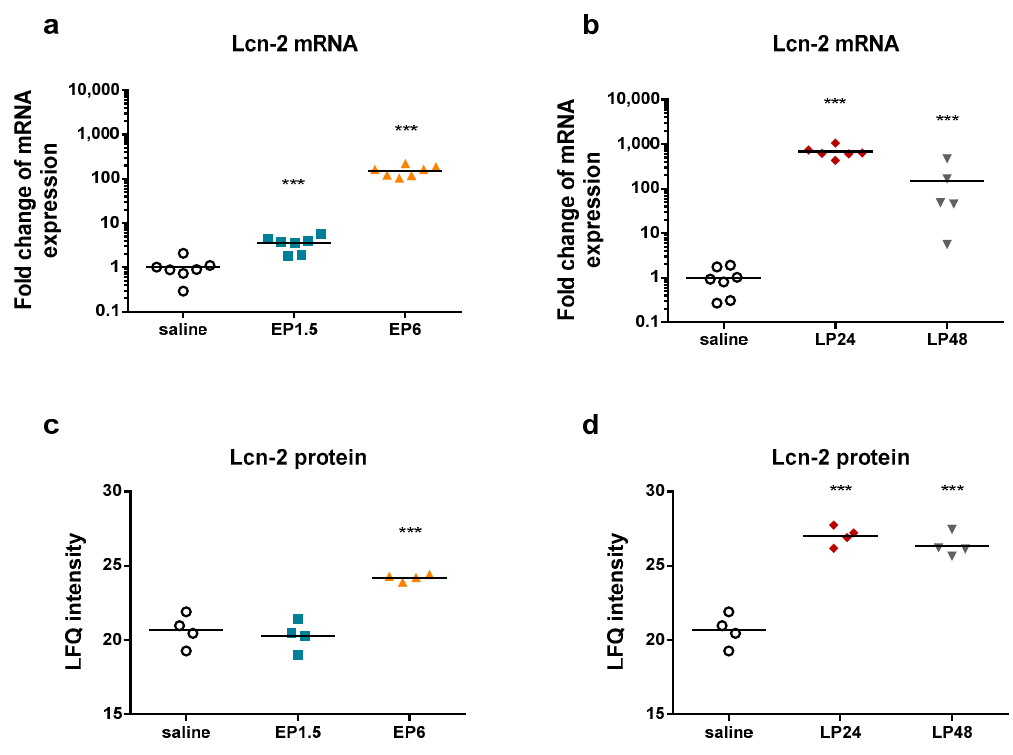
Figure 2. Lipocalin-2 mRNA and protein expression relative to saline-treated control kidneys in mice after LPS administration. ***: p ≤ 0.001. ( a ) Fold changes of Lcn-2 mRNA in EP1.5 and EP6 groups. ( b ) Fold changes of Lcn-2 mRNA in LP24 and LP48 groups. ( c ) Label-free quantification (LFQ) intensity values (relative amount) of Lcn-2 protein determined by mass spectrometry in EP 1.5 and EP6 groups. ( d ) LFQ intensity values of Lcn-2 protein determined by mass spectrometry in LP24 and LP48 groups.